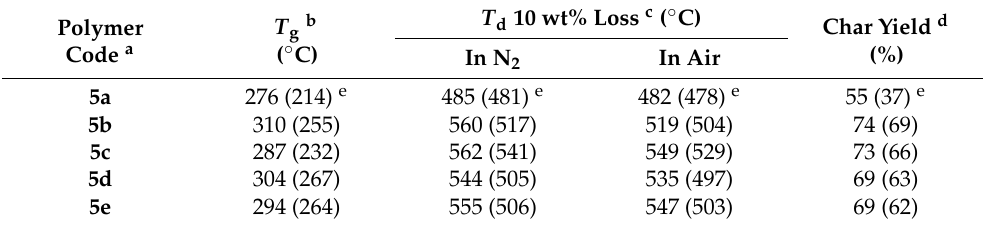
Table 2. Thermal behaviors of polyamides.